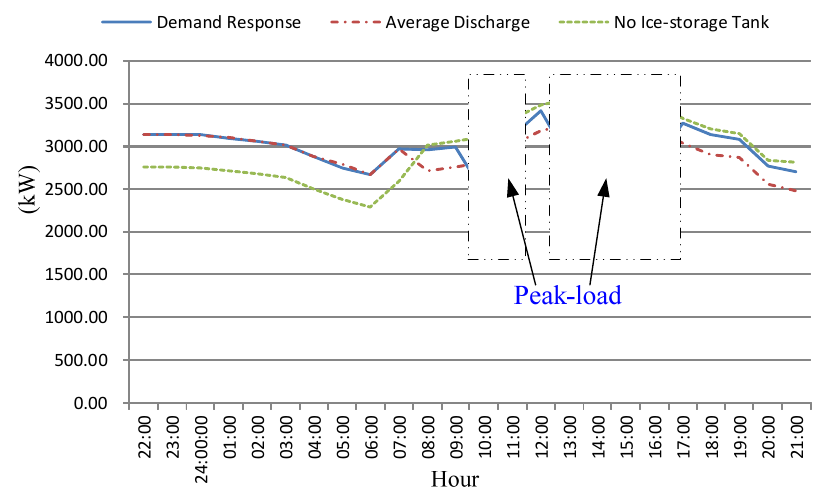
Figure 9. Simulation of dynamic electricity price.